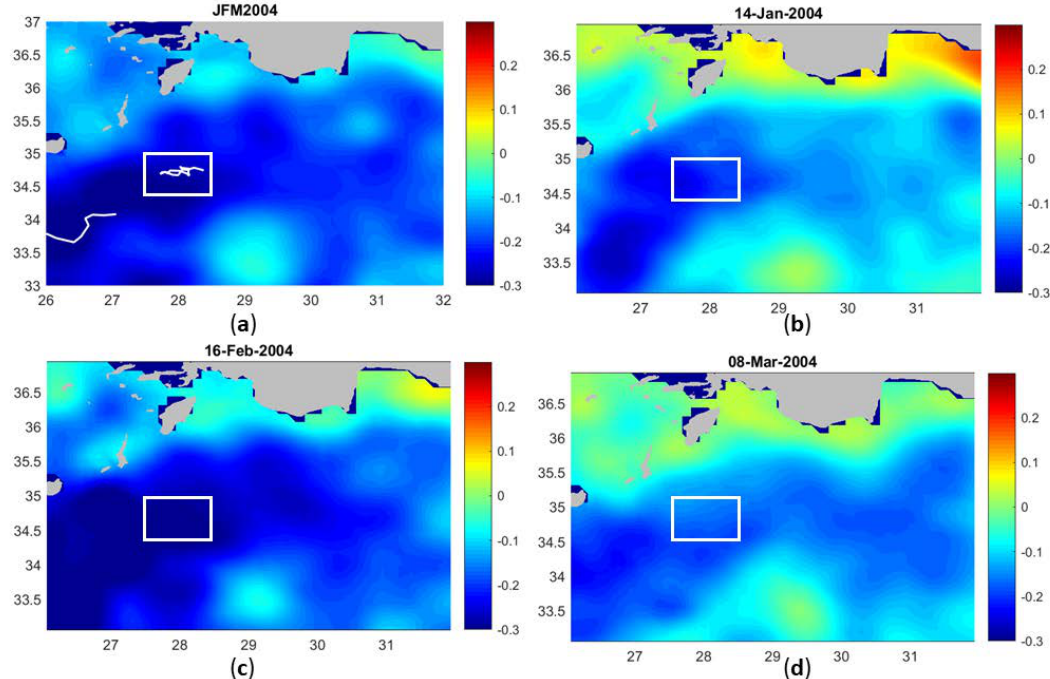
Figure 15. ( a ) mean SSH (m) for JFM 2004 and float trajectory of float WMO 6900098 (white rectangle). ( b ) SSH (m) for the 14 January 2004; float profiles show ‘regular’ winter MLDs around 150 m. ( c ) SSH (m) for the 16 February 2004; float profiles reveal dense water formation to about 350 m; ( d ) SSH (m) for 8 March 2004; recapping with a newly formed MLD of about 80 m occurred, while the dense water formation event down to 450 m is still captured by the float profile. Monthly means of satellite SST are shown in Figure 16. The satellite SST reached a minimum between mid-February and mid-March, i.e., during the event of deep water formation, and coincides with the surface potential temperature measured by the Argo float (Figure 12).